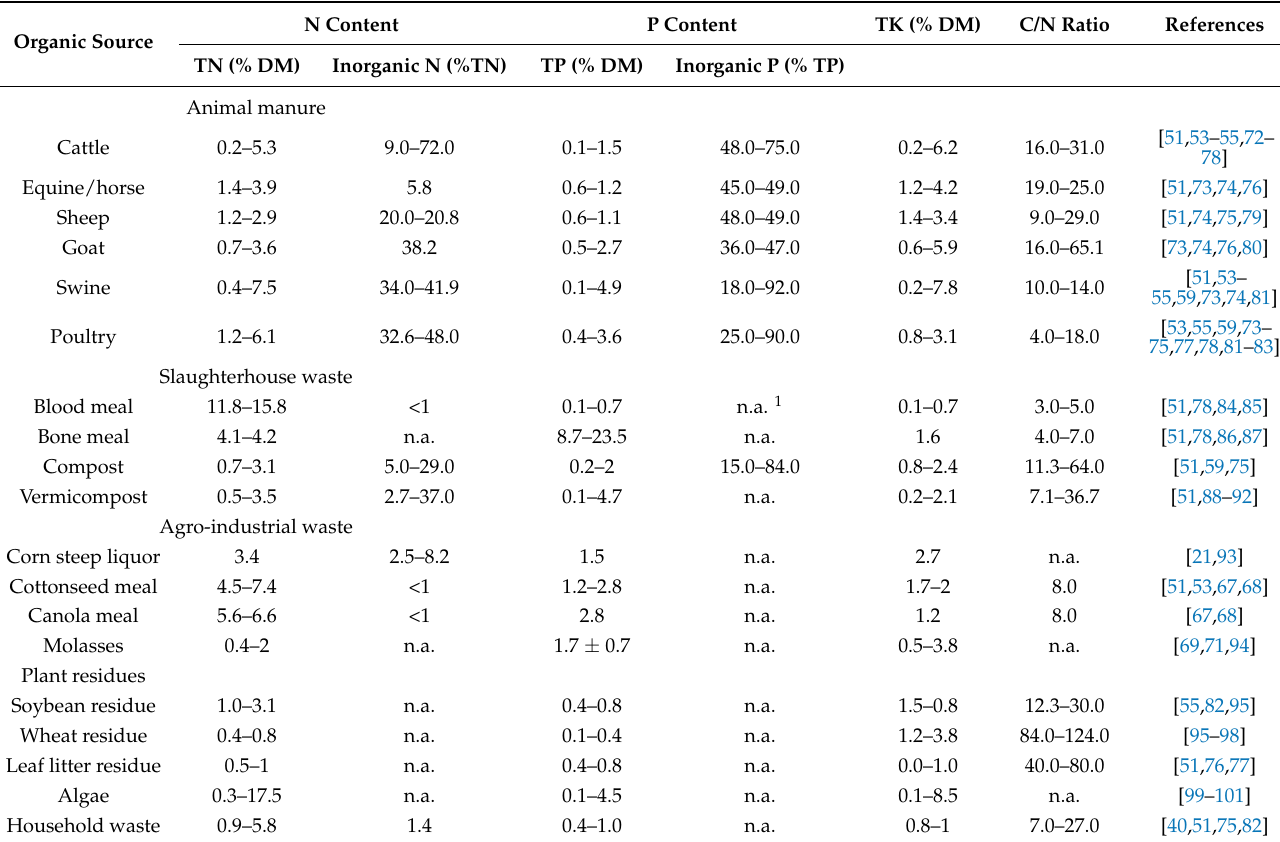
Table 1. Nutrient content (N, P, K) and C/N ratio of commonly used organic fertilizers. TN, total nitrogen; TP, total phosphorus; TK, total potassium; DM, dry